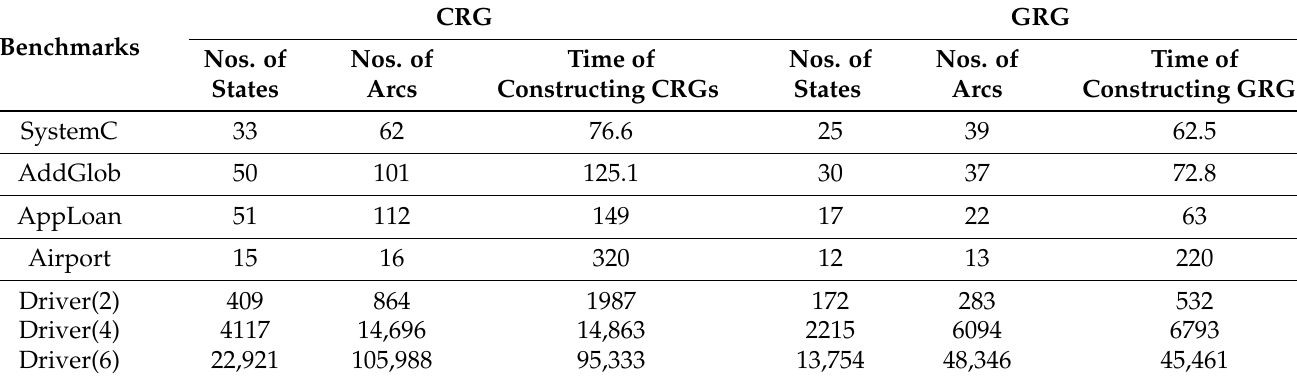
Table 4. The experimental results of GRG and CRG in DICER 2.0.